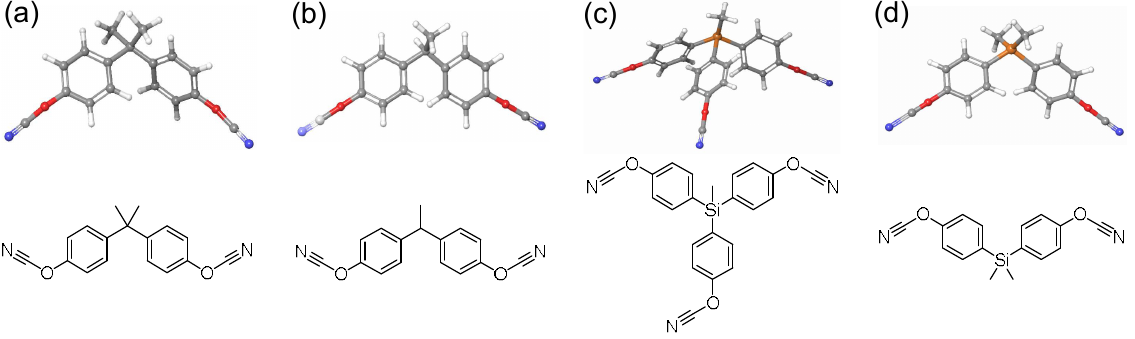
Figure 1. Chemical structures and three-dimensional illustrations of monomers: ( a ) 2′-(4-cya- natophenyl)propane (BADCy), ( b ) 4,4′-(ethane-1,1-diyl)bis(cyanatobenzene) (LECy), ( c ) tris(4-cyan- tophenyl)methylsilane (SiCy-3), and ( d ) bis(4-cyanatophenyl)dimethylsilane (SiMCy).